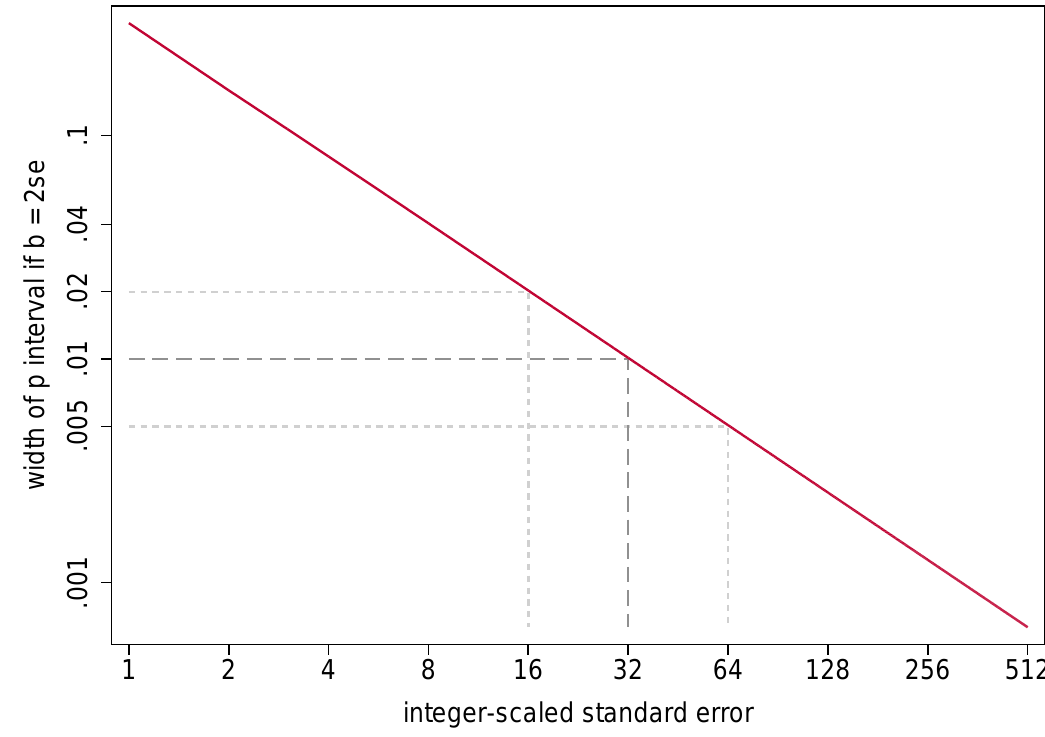
Figure 2: The integer-scaled standard error and the width of the interval of possible p -values. affords a particular level of precision when p is approximately 0.05 only improves as p